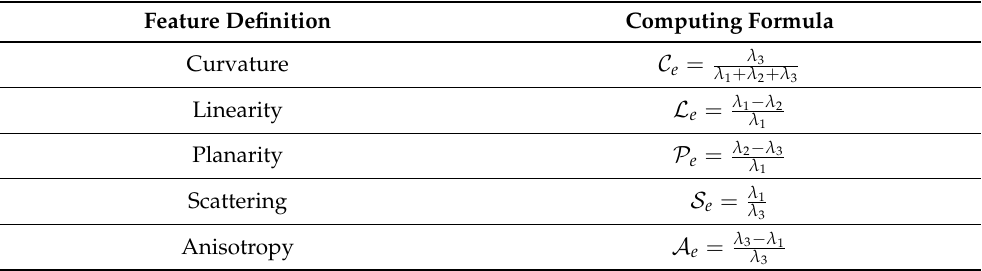
Table 1. Computing method for eigenvalue-based shape features. Feature definitions on the left are described in Section 3.3.2. Three eigenvalue symbols are sorted in descending order from 1 to 3 in the